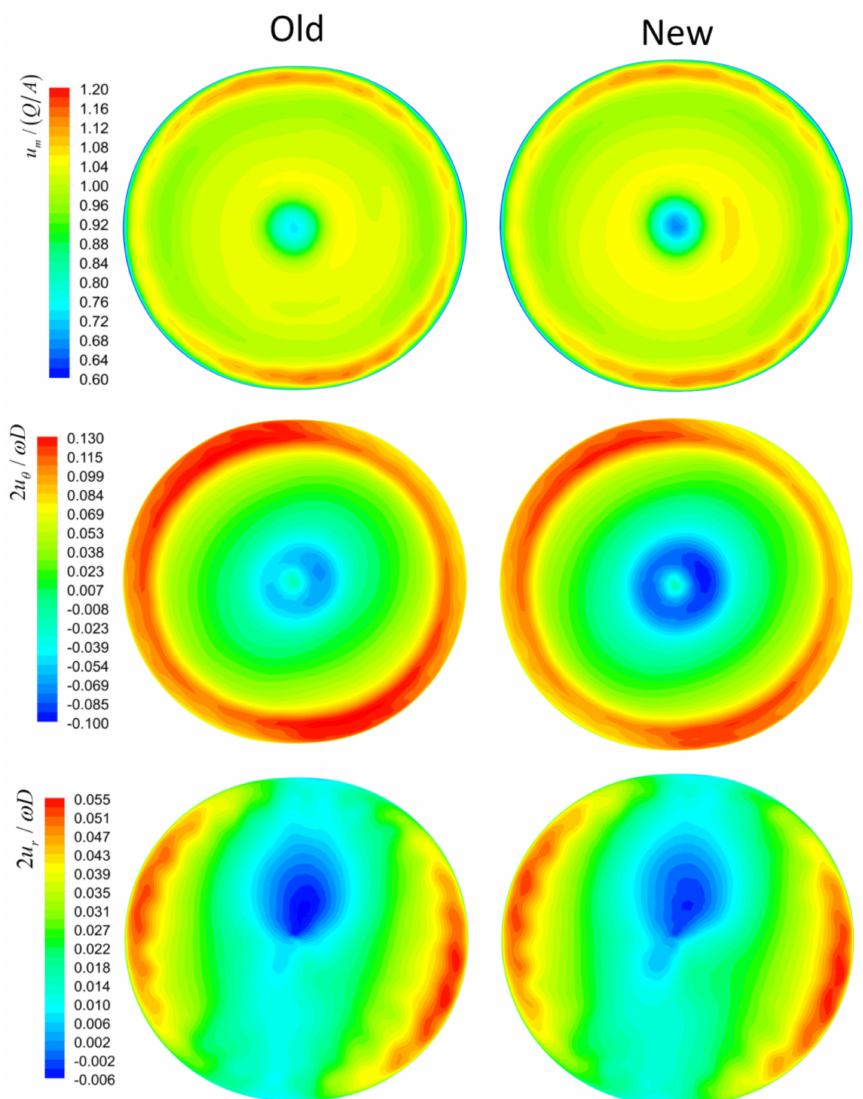
Figure 24. Axial, circumferential and radial flows at runner outlet of case 2 hydraulic turbine. Axial velocity is function of the inlet area of the draft tube and the turbine